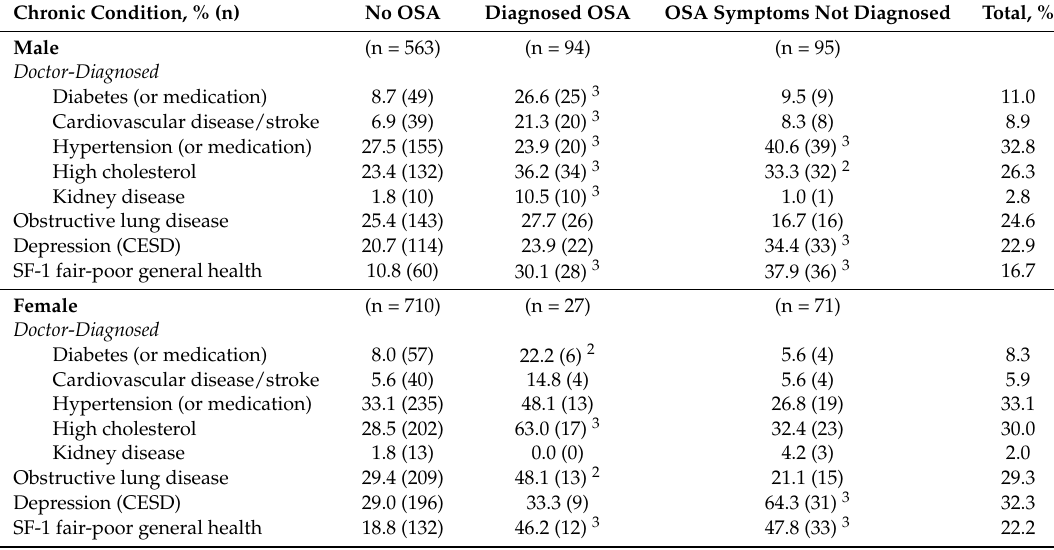
Table 3. Prevalence of chronic conditions (%, (n)) in participants with diagnosed of OSA or with OSA symptoms (snoring and daytime sleepiness 1 ) not previously diagnosed, by sex.